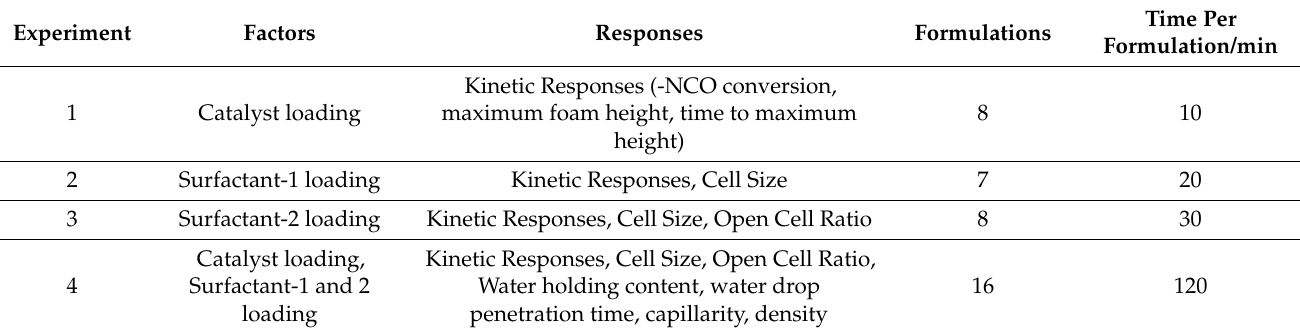
Table 3. Table of the DoE factors, responses, the number of formulations and time per formulations for the four iterative